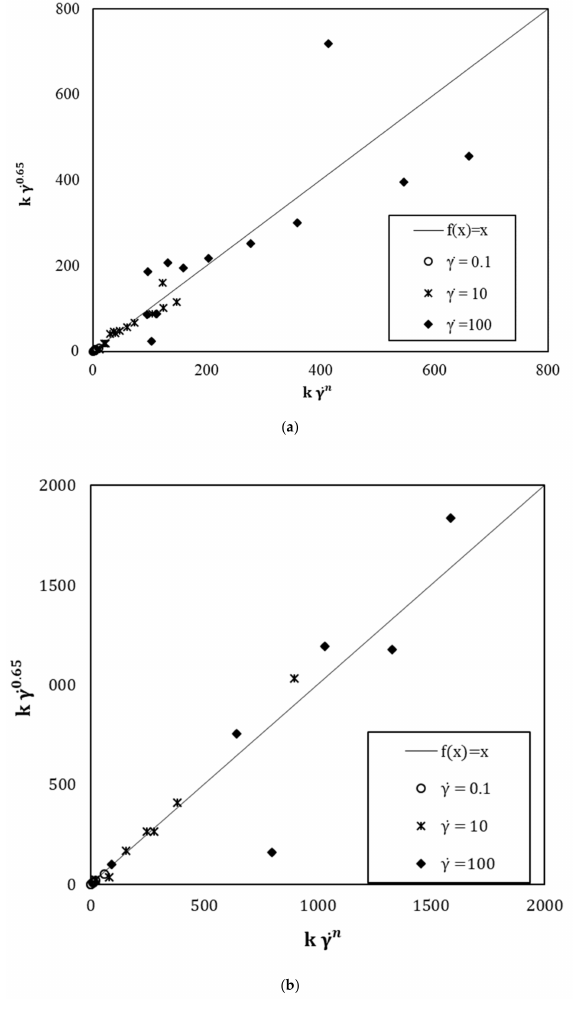
. . γ 0.65 with k γ n for ( a ) cement pastes and ( b ) mortar